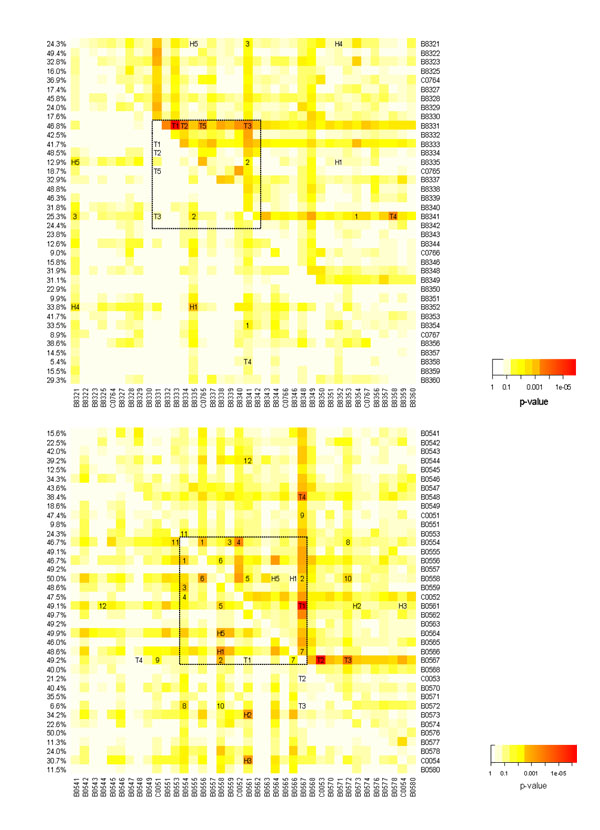
Two-SNP results for KA population on chromosome 9 (top) and DA population on chromosome 1 (bottom). HST p-values are below the diagonal; TRANSMIT p-values are above; estimated minor allele frequencies are on the left margin. The square identified by "i" represents the ith most significant (by both HST and TRANSMIT) SNP pair ranked by the sum of the TRANSMIT and HST p-values. For example, in the top panel, "3" (in the first row) means that HST and TRANSMIT p-values for pair B8321–B8341 are both significant and the sum of their p-values is the third most significant. Hj and Tj represent the jth significant SNP pair by HST and TRANSMIT, respectively. Note, on the top panel, "2"-H2, "3"-H3 coincide; only "2" and "3" are identified. Similarly for the bottom panel, "4"-T5, "6"-H4 coincide and only "4" and "6" are identified.